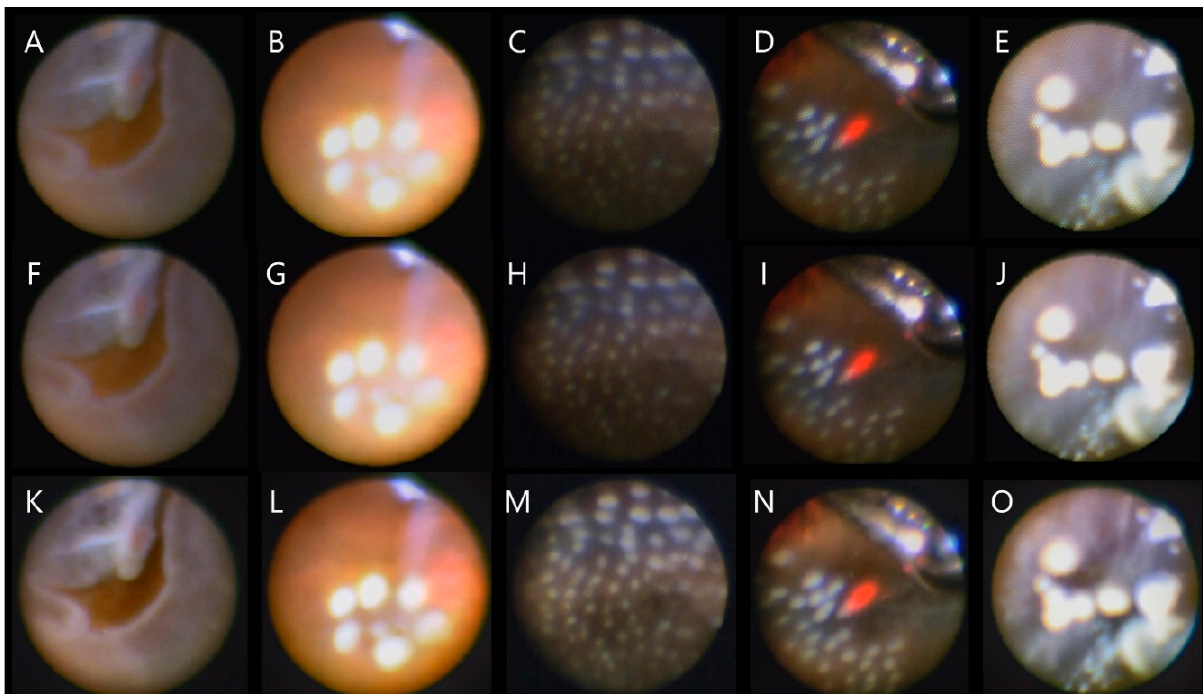
Figure 1. Original images ( A – E ), images after honeycomb-removal process ( F – J ), and images after both honeycomb-removal and image-sharpening procedures ( K – O ). Image processing significantly improved endoscopic visibility, including more detailed observation of lattice degeneration next to a retinal tear ( K ), a small retinal hole surrounded by laser photocoagulation ( L ), a retinal break and laser responses under air infusion ( M ), retinal lesions at ora serrata ( N ), and asteroid hyalosis ( O ). The results of image visibility evaluation are shown in Figure 2. The visibility score was significantly improved from 4.27 ± 1.78 for the original images to 4.72 ± 2.00 for the images after the honeycomb-removal process ( p < 0.001), and to 5.40 ± 2.10 for the images after both honeycomb-removal and image-sharpening procedures ( p < 0.001). When the visibility scores were analyzed separately for 10 surgeons who were familiar with endoscopic vitrectomy and eight surgeons who were not, similar results were obtained (Figure 3).